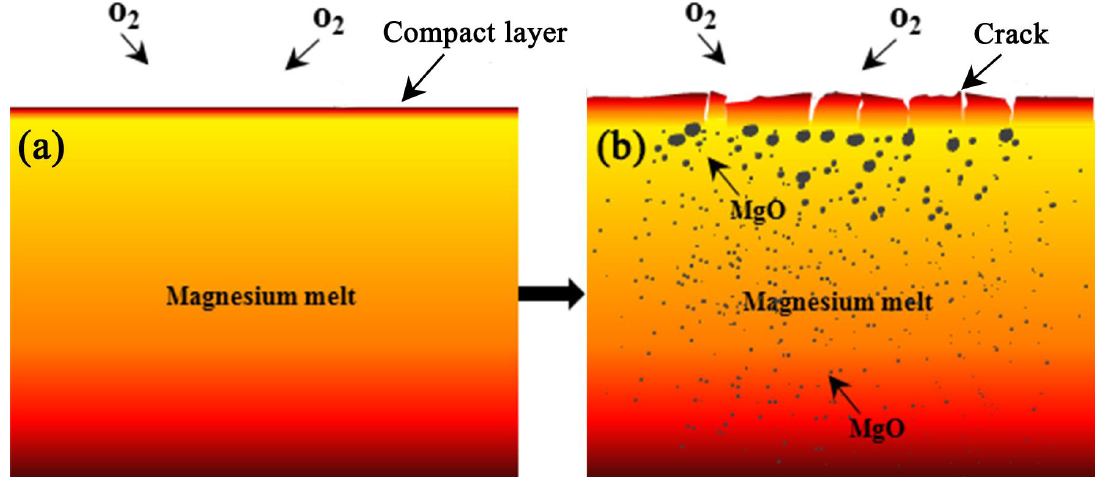
Figure 4. Schematic of the stages for MgO growth on the surface of magnesium melt: (a) the initial state of magnesium melt; (b) distribution of different size of MgO in magnesium melt Table 3. Voigt ( index V ), Reuss ( index R ), and averaged macroscopic modulus for the Mg and MgO phase; all in Gpa except for ν ( dimensionless )